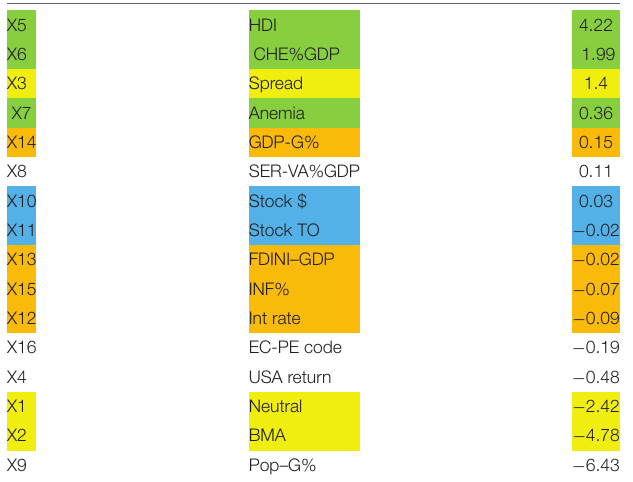
TABLE 17 | Feature Importance in India Testing Set.